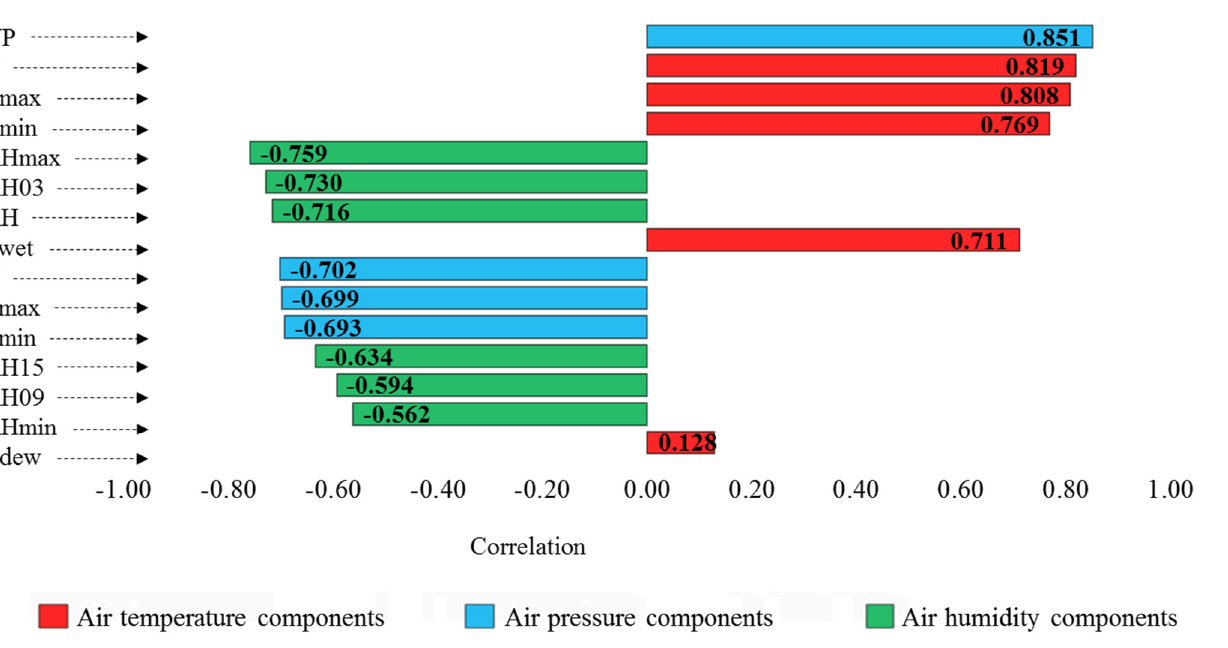
Figure 4. Results of Pearson correlation test between the meteorological variables and pan evapora- tion (sorted due to the correlation intensity).